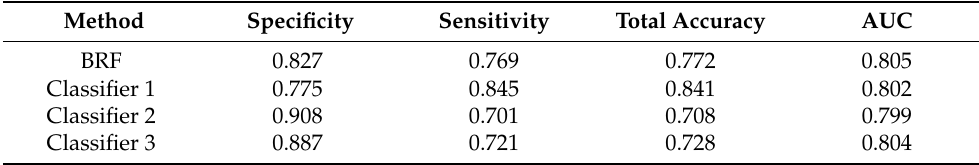
Table 4. Results for improved